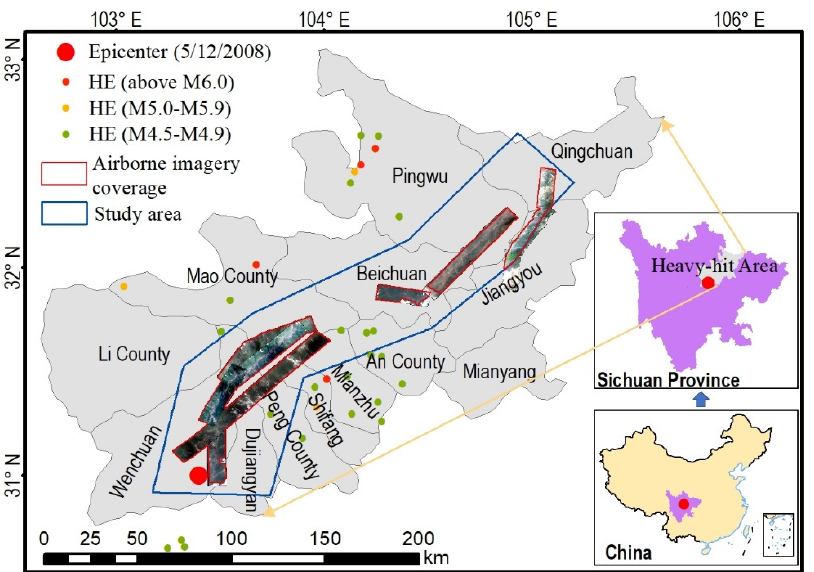
Figure 1. Location of the study area. The gray color area which cover 13 counties is the heavy hit mountain area of the Wenchuan earthquake. The abbreviation of HE represents of historical earthquake.